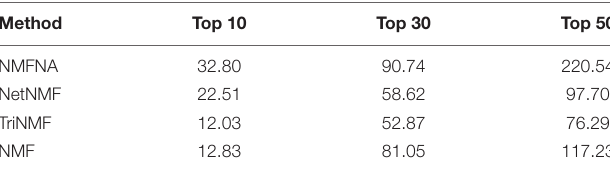
TABLE 4 | Summated relevance scores of characteristic genes in both ME and CNV core modules identified by each compared method.